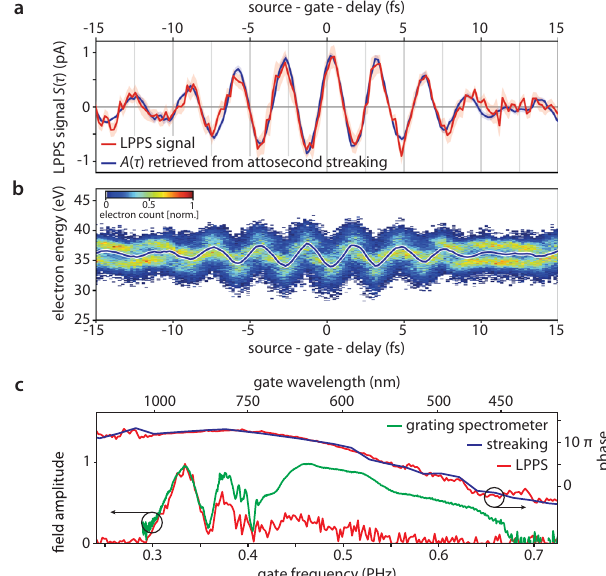
Fig. 2 Optical fi eld sampling using linear petahertz photoconductive sampling (LPPS). a LPPS signal S ( τ ) (red line, standard deviation red- shaded area) as a function of the source-gate-delay (the source pulse precedes the gate pulse for negative delays) at a gate intensity of 1.7 V/nm compared to the vector potential of the gate laser electric fi eld retrieved via attosecond streaking A ( τ ) (blue, standard deviation blue-shaded area). b Attosecond streaking spectrogram (false color plot) and extracted steaking momentum shift (solid line). The streaking momentum shift is linearly proportional to the negative vector potential of the gate laser pulses (blue line in panel ( a )). c Spectral amplitude and phase of the electric fi eld of the gate laser pulses retrieved via differentiation of the vector potential retrieved via LPPS (red) compared to the spectral phase retrieved via attosecond streaking (blue) and the gate fi eld spectral amplitude measured with a calibrated grating spectrometer (green). See the “ Methods ” section and Supplementary Fig. 1 for